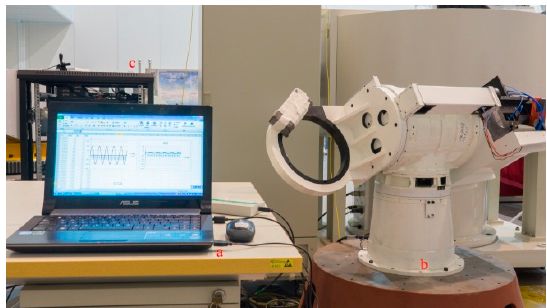
Figure 8. Ground-based laser communication servo turntable experimental platform: ( a ) master computer; ( b ) ground-based laser communication servo turntable; ( c ) digital controller (power amplifier).